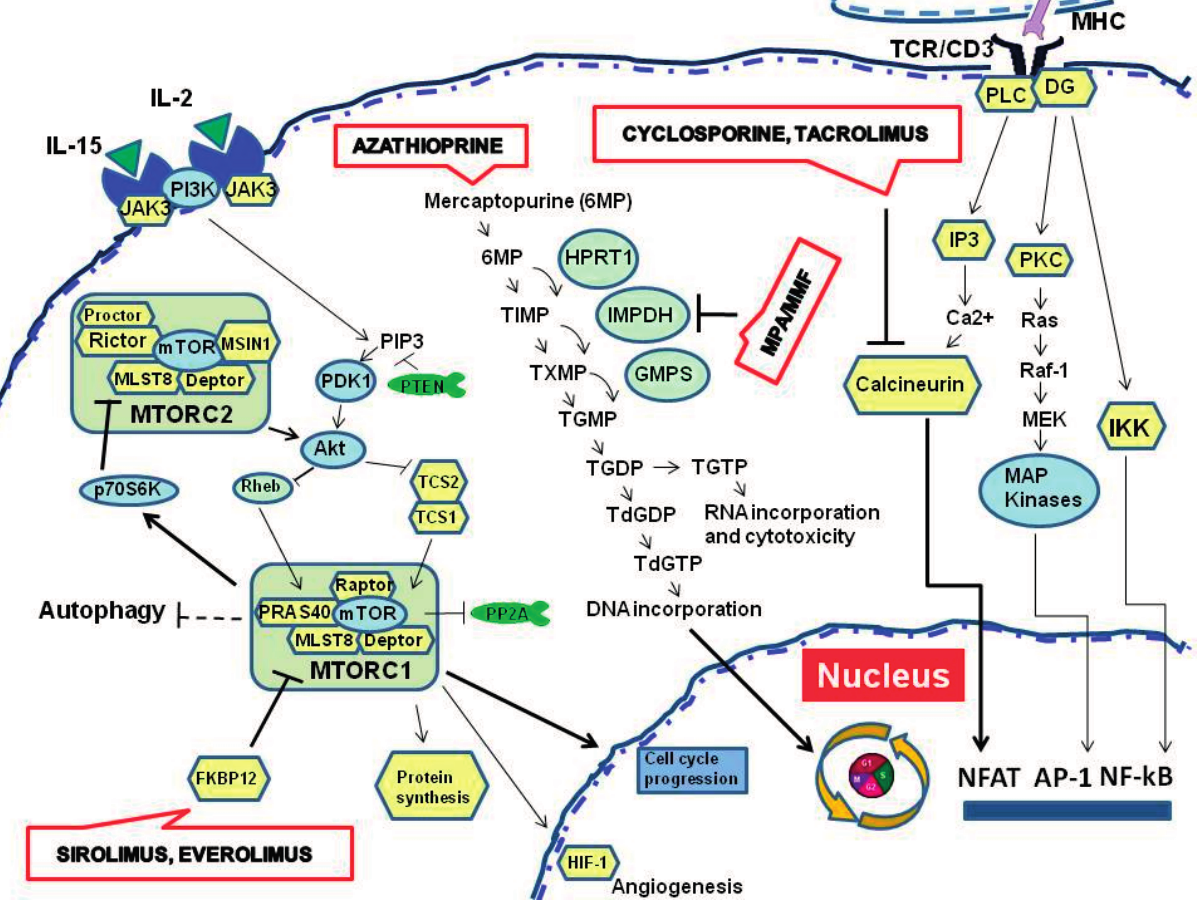
Figure 2. Mechanisms of action and targets of immunosuppressive drugs used in renal transplantation. MPA: Micophenolic acid; MMF: Mycophenolate